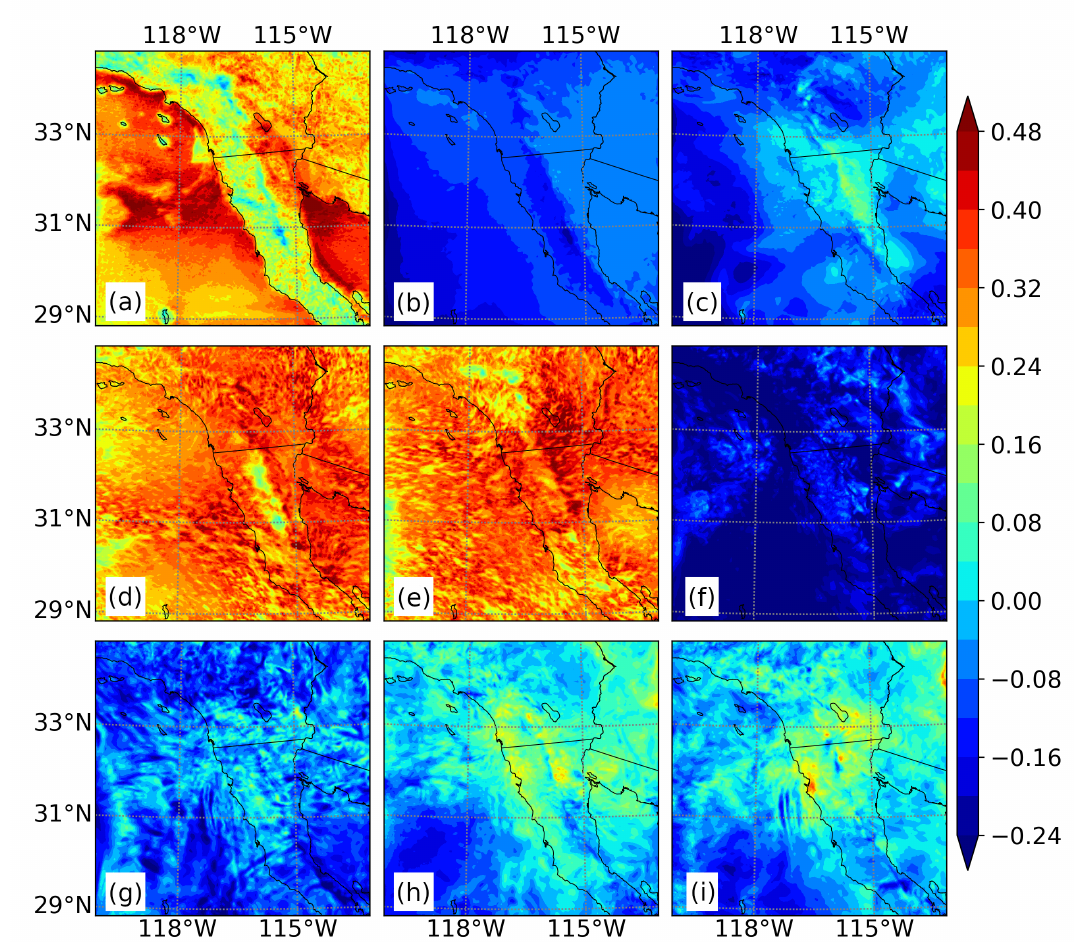
Figure 6. Time and vertically-averaged growth rate of the perturbations during the simulation period starting at 00Z on 27 February 2017. The members presented are Cu09ur ( a ), Op31ur ( b ), Op71ur ( c ), Su01ur ( d ), Su05ur ( e ), Bp31po ( f ), Bp71po ( g ), Bp01us ( h ), Bp05us ( i